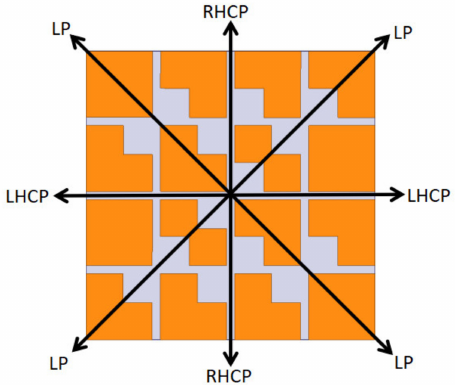
Figure 2. Antenna polarization at di ff erent rotation angles.